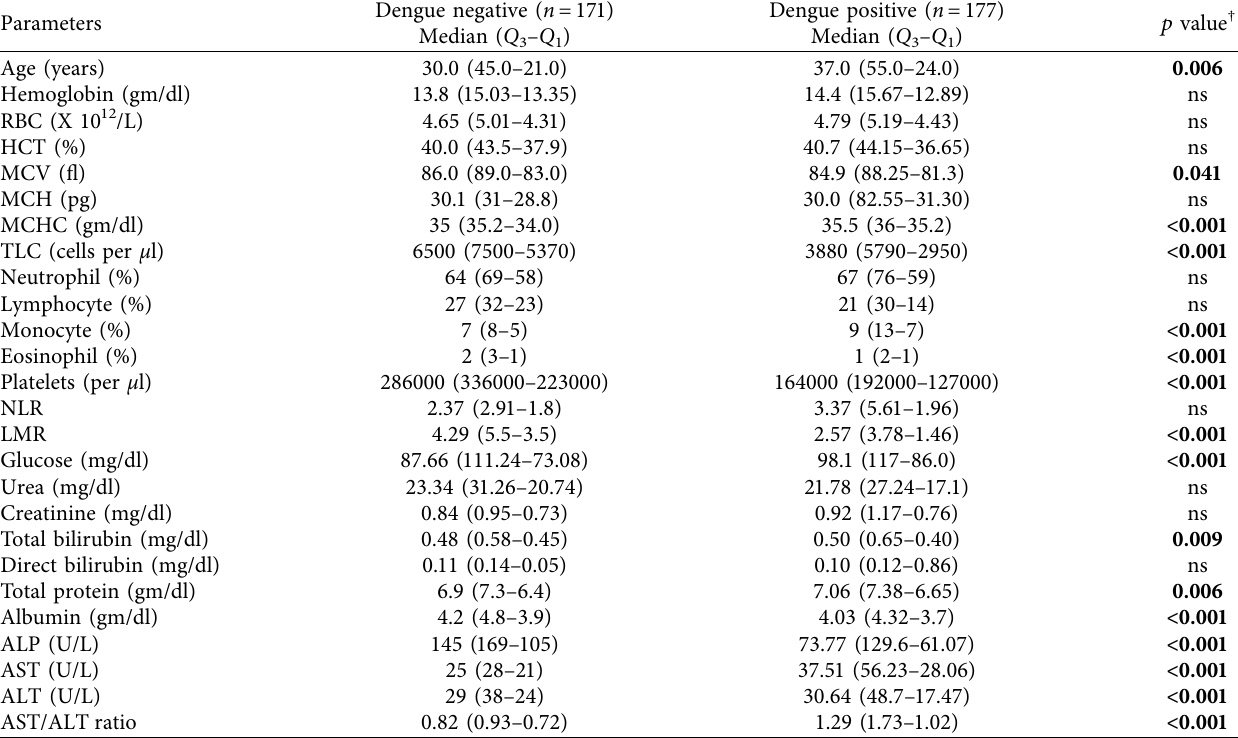
Table 1: Hematological and biochemical fndings in study